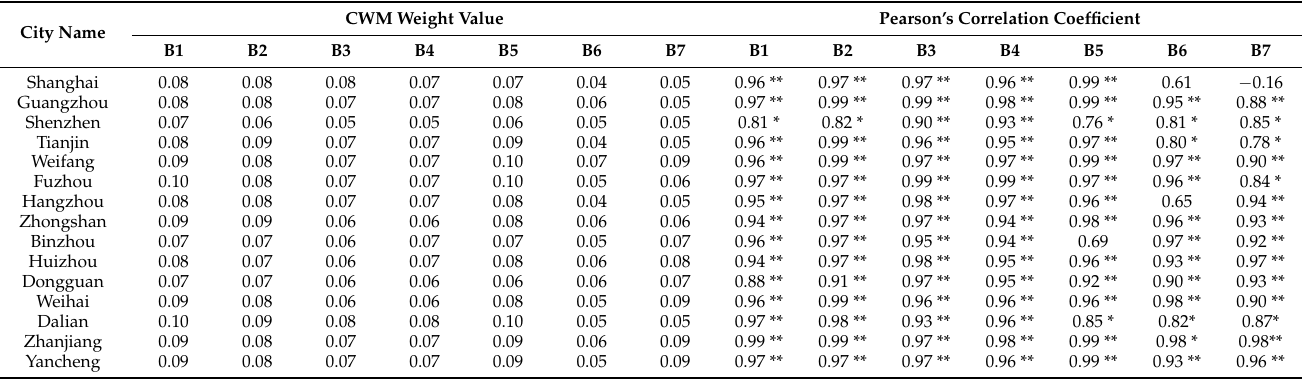
Table A5. The weight values and vulnerability correlation values of the adaptability index of 15 coastal